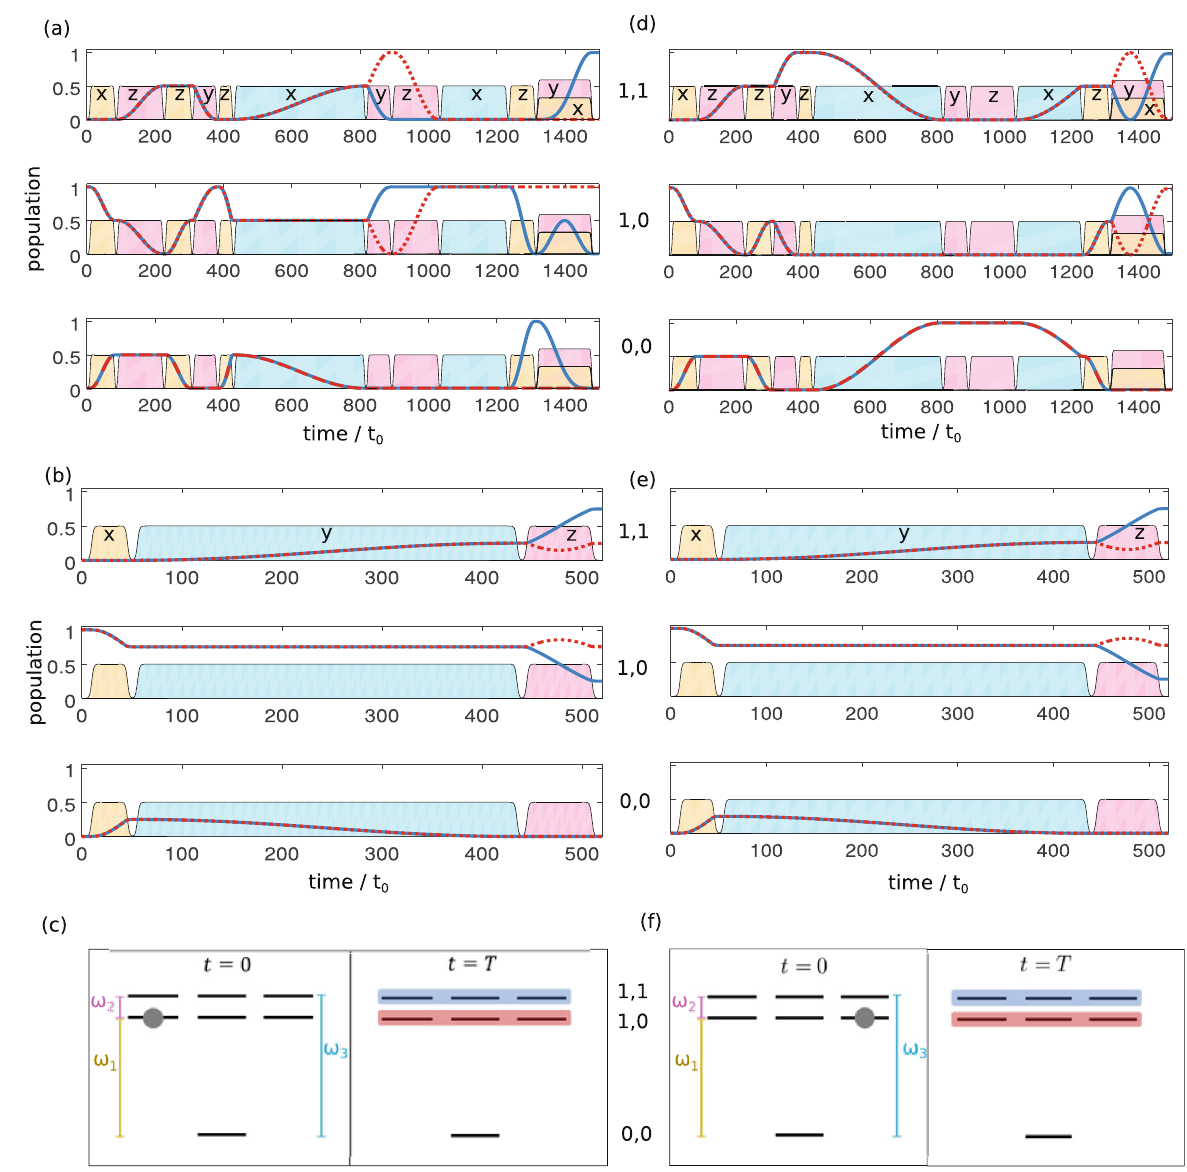
Fig. 5 Full control of enantiomer-selective state transfer with fi ve different fi elds. a – c They depict the population dynamics for the initial states J ¼ 1 ; τ ¼ 0 ; M ¼ (cid:2) 1 j i and d – f , display the dynamics for the initial state J ¼ 1 ; τ ¼ 0 ; M ¼ 1 j i , where J , τ , and M are the quantum numbers of the asymmetric top. a and d These show the population in the rotational levels J , τ = 1, 1, J , τ = 1, 0 and J , τ = 0, 0, averaged over the degenerate M -states for a pulse sequence with fi ve different fi elds which ensure complete enantiomer-selective control. For comparison, b and e display the incomplete enantiomer- selective state transfer in standard three-wave mixing cycles. The two enantiomers are denoted by solid blue and dashed red lines. The pulse envelopes are indicated by orange ( ω = ω 1 ), pink ( ω = ω 2 ), and turquoise ( ω = ω 3 ) shapes. The height of these shapes indicates the maximal electric fi eld strength (in arbitrary units) and the polarization is denoted by x , y , and z . Time is given in units of t 0 = ℏ / B , where B is a rotational constant. The details of the pulse shapes are given in Supplementary Information 2. c and f illustrate the initial ( t = 0) and fi nal ( t = T ) populations. The gray circles mark the states which are initially populated by both enantiomers. The blue (red) shapes indicate which states are fi nally populated by enantiomer 1 (enantiomer 2). The vertical bars show the frequencies ω 1 (orange), ω 2 (pink), and ω 3